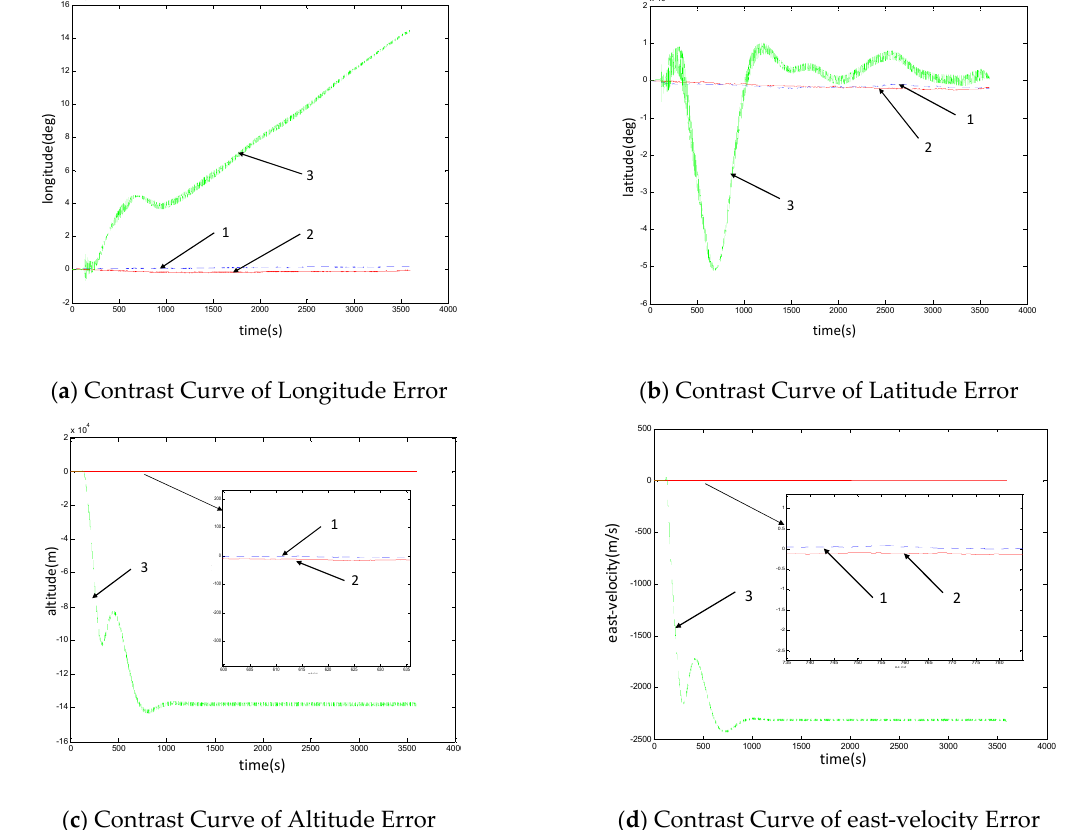
Figure 7. Contrast Diagram of System Fusion Navigation results when the inertial sensor fails but is not isolated.